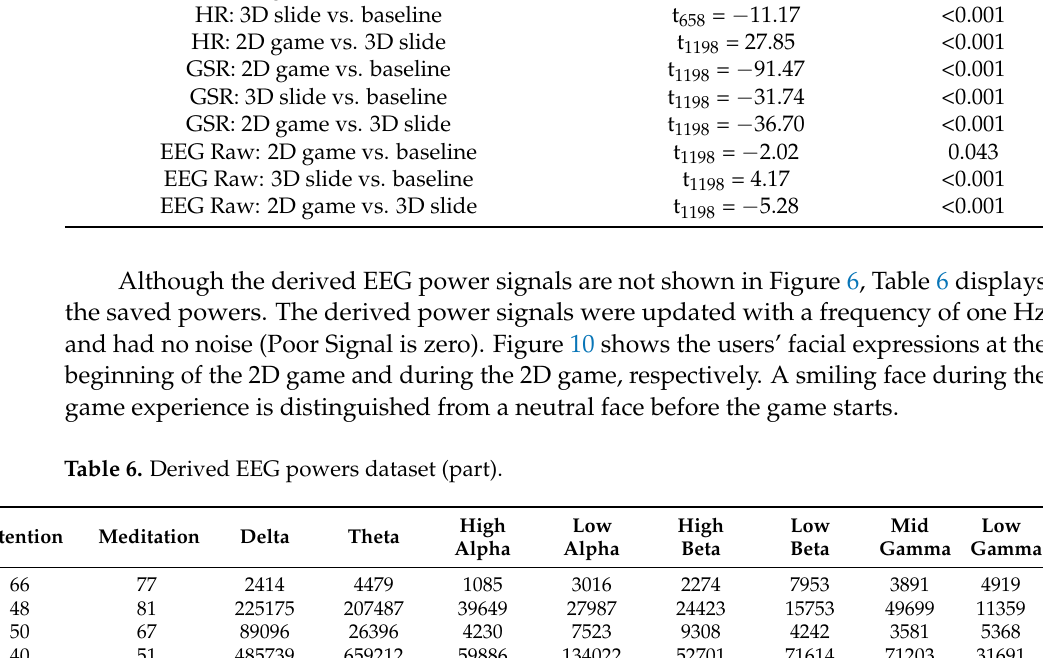
Table 5. Two sample t -test for HR, GSR, and EEG raw data use paired combinations for the baseline,